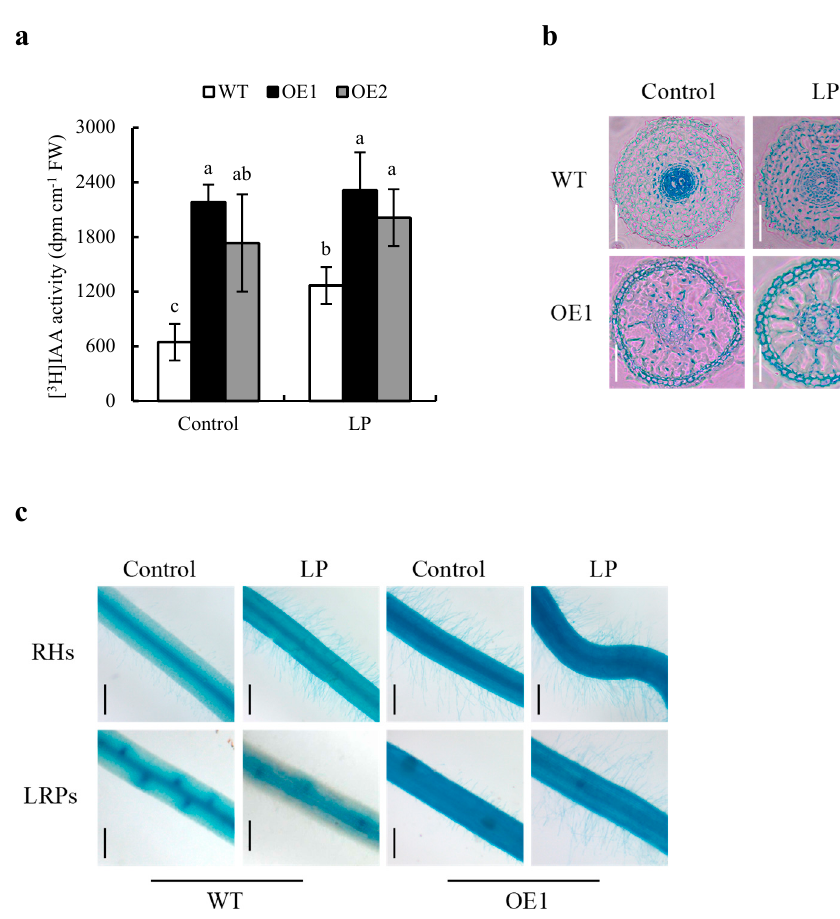
Figure 7. [ 3 H]IAA transport and histochemical localization of DR5::GUS and root hair (RH) and lateral root primordia (LRP) formation. Seedlings were grown in hydroponic media containing normal nutrition (control; 2.5 mM N, 300 µ M P) or low P (LP, 10 µ M) for 7 d. ( a ) IAA transport for acropetal. ( b ) DR5::GUS distribution in transverse section. ( c ) RHs and lateral root primordia (LRPs) formation. d = days. Bar = 0.2 mm ( b ) and Bar = 0.5mm ( c ). Data are means ± SE and bars with di ff erent letters indicate significant di ff erences in the same gene ( p < 0.05, ANOVA). All experiments included three independent biological replicates.